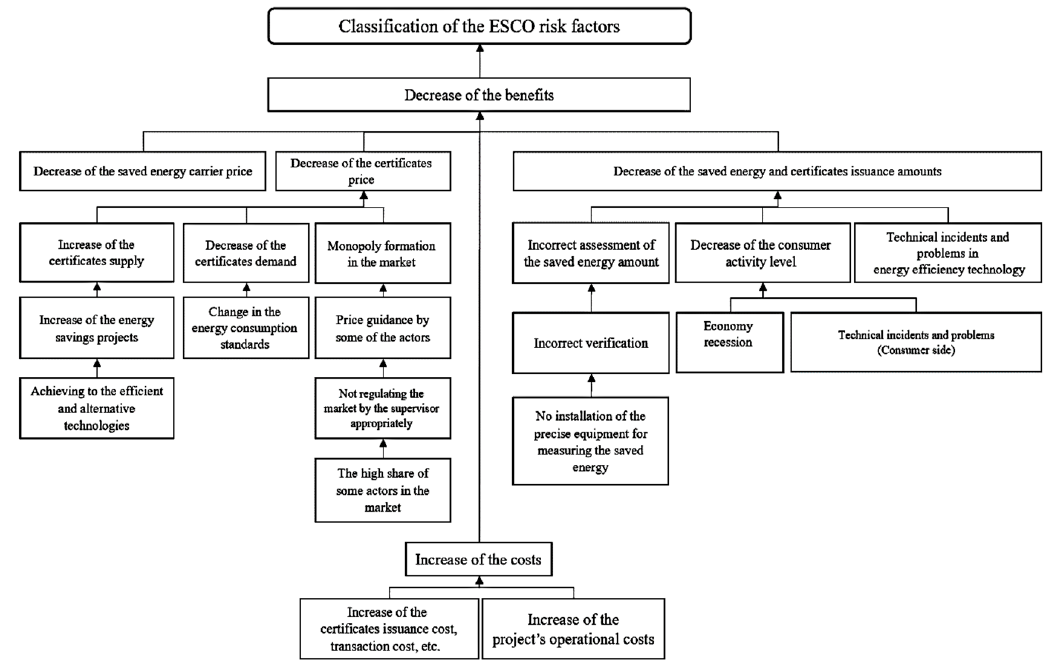
Figure 5. Classification of the risk factors in the ESCO business by consideration of the ESC market (Source: authors classification).